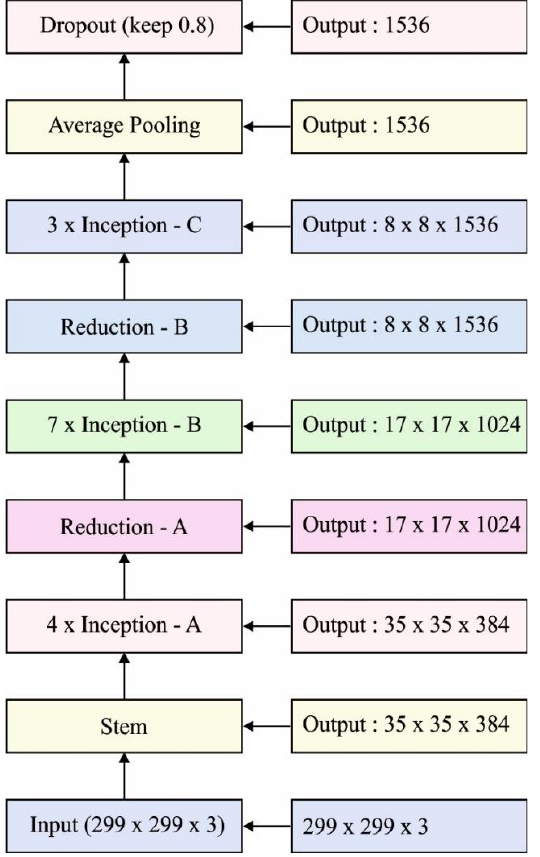
Figure 2. Network schema of Inception v4.